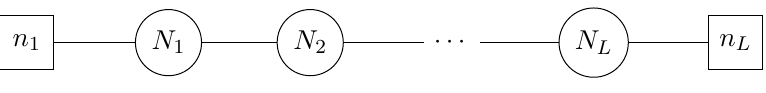
Figure 18 . Admissible linear quiver when ν ( z ) is of class C 2 ([0 , 1]) .